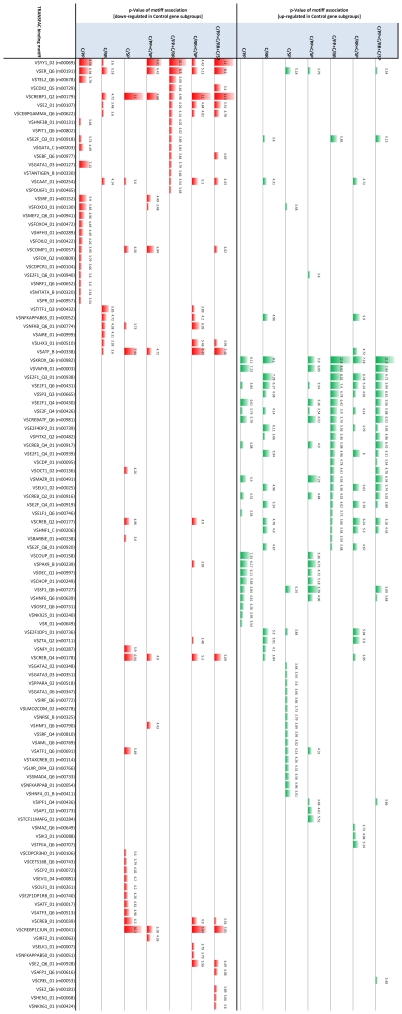
TRANSFAC motif profiles for the up- (red bars) and down- (green bars) regulated signature subsets.Profiles for subset unions are also shown; for instance C/PP+C/RR contains the up (red) or down (green) regulated genes from the union of the C/PP and C/RR signatures (Figure 8 depicts all the signature subsets and subset unions.) The bottom row (blue bars) is the profile for all genes in the C/PP, C/RR and C/SP signatures. Size of bar is proportional to the negative natural logarithm of p-value, which is also given as a number. Only significant motifs (p-value ≤0.05) are shown.